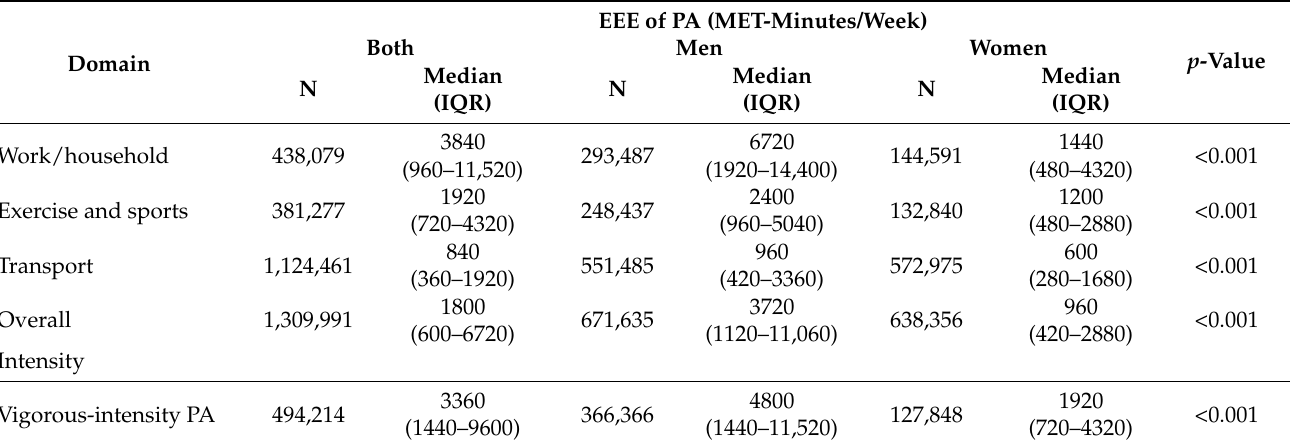
Table 3. Median and interquartile range (IQR) of the estimated energy expenditure (EEE) of physical activity (PA) measured in MET-minutes/week by domain and in total according to sex among participants aged 18–64 years. Panama,